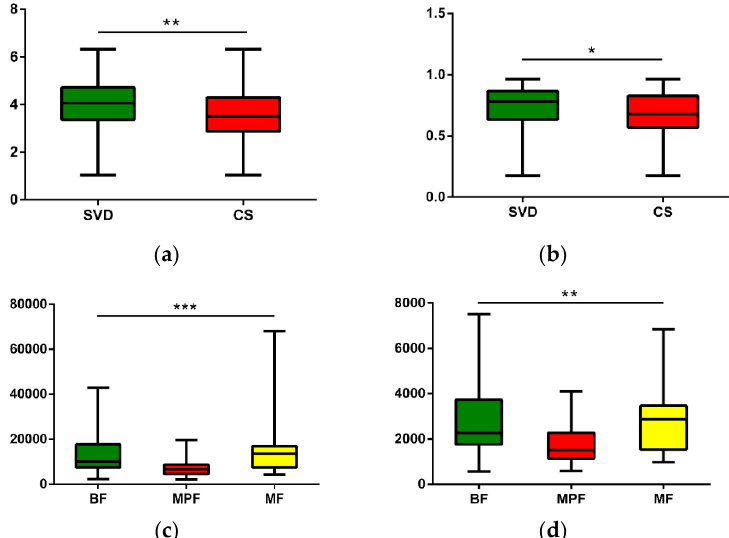
Figure 3. Alpha diversity analysis of infant gut microbiota in di ff erent delivery modes and feeding methods. ( a ) Delivery modes, Shannon ( p < 0.01); ( b ) Delivery modes, Simpson ( p < 0.05); ( c ) Feeding methods, Chao1 ( p < 0.001); ( d ) Feeding methods, Observed species ( p < 0.01). * p < 0.05, ** p < 0.01, *** p <